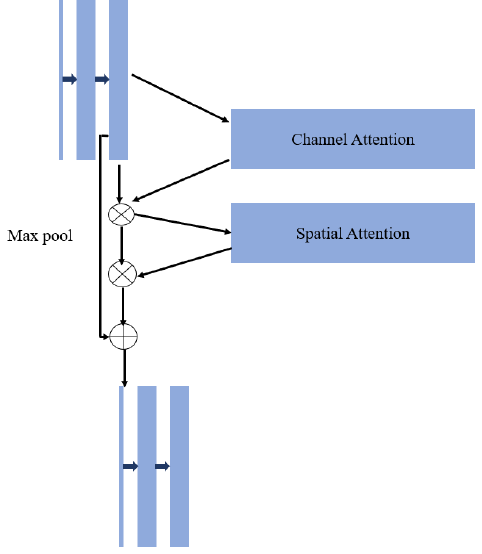
Figure 3. Improved partial algorithm model structure.